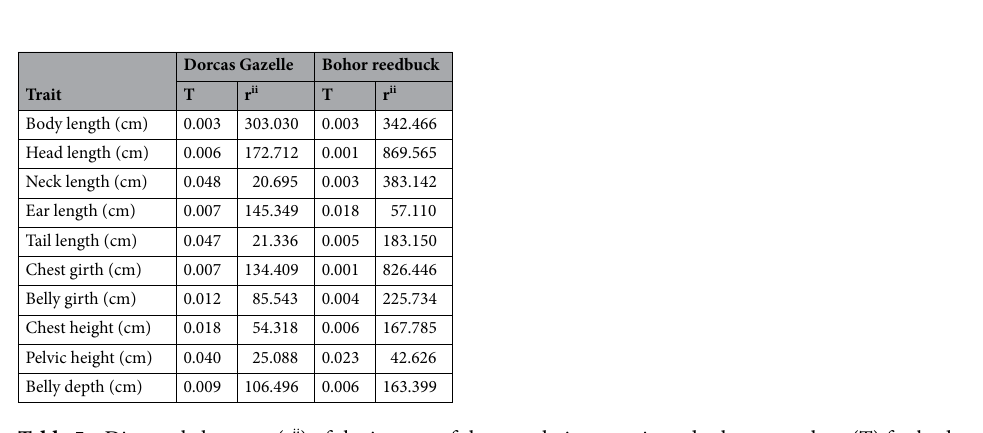
Table 5. Diagonal elements (r ii ) of the inverse of the correlation matrix and tolerance values (T) for body measurements of Dorcas gazelle and Bohor reedbucks.